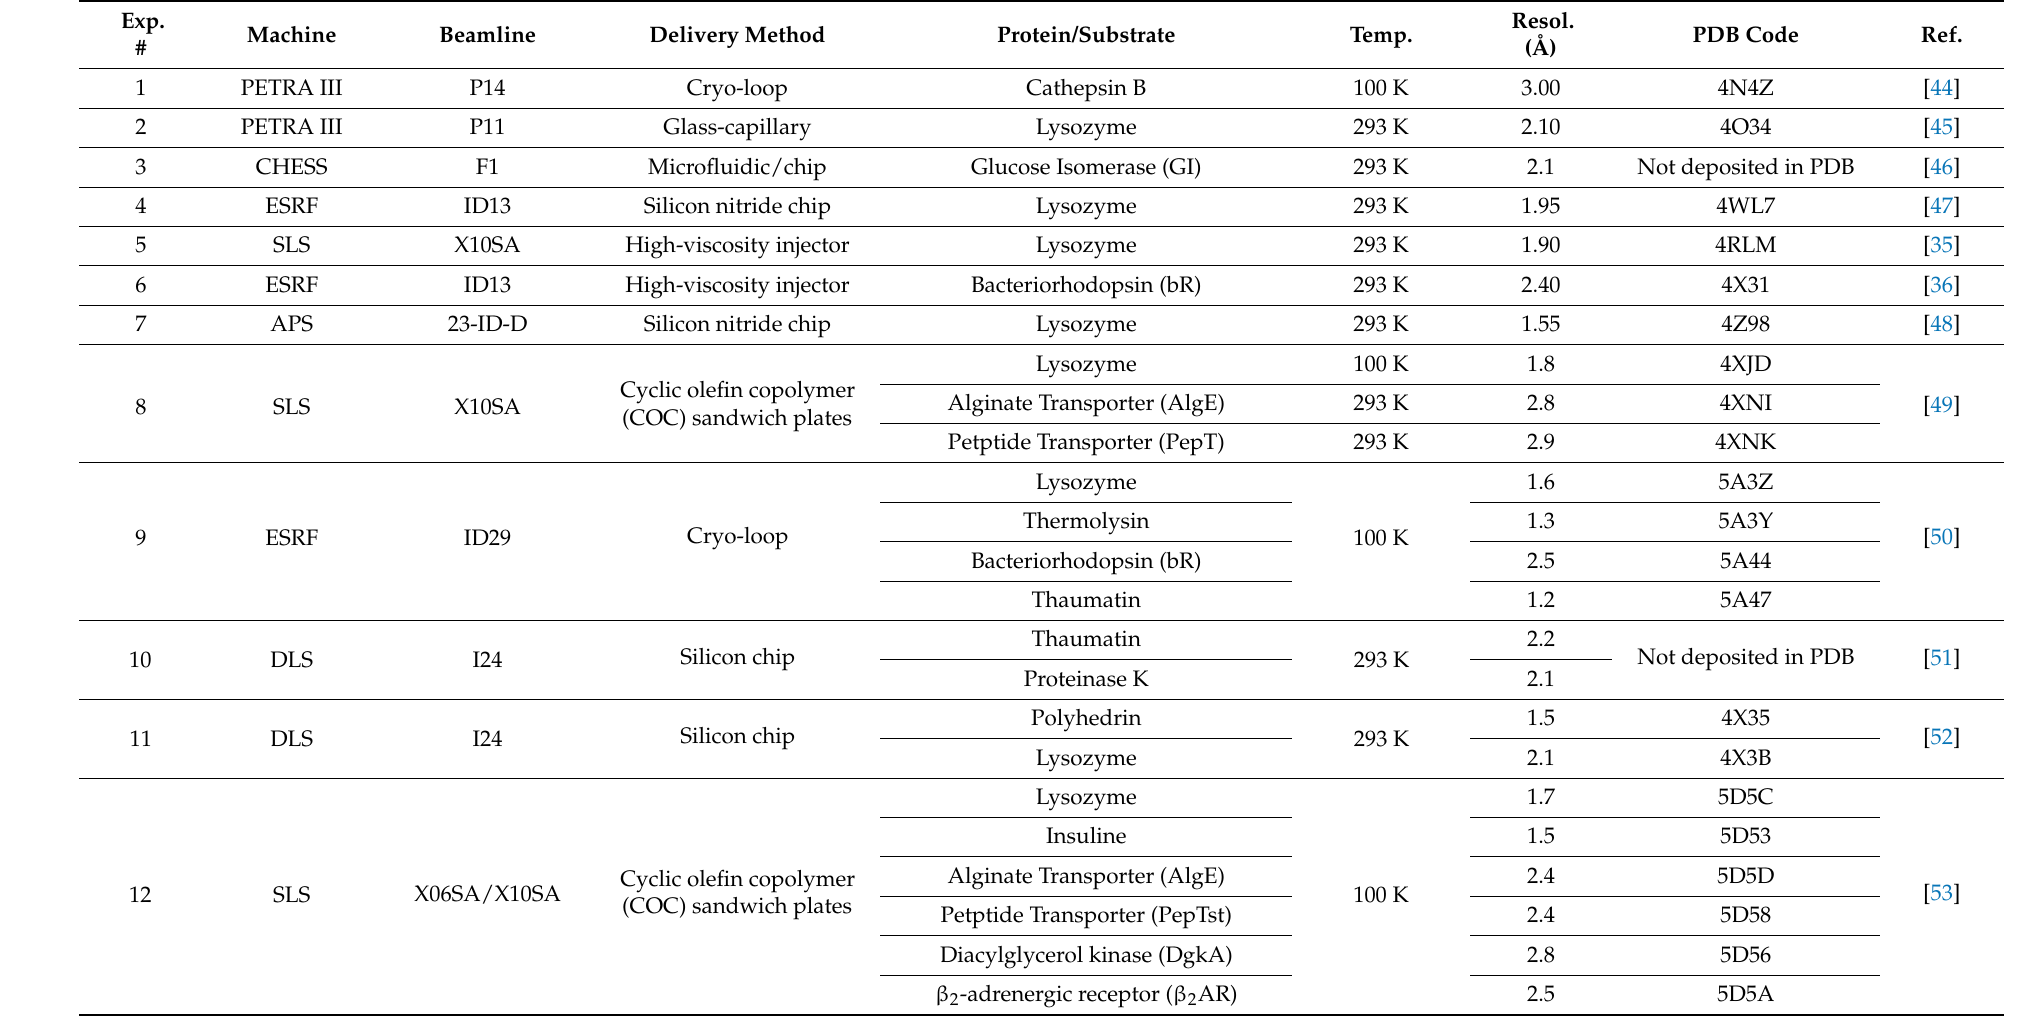
Table 1. SMX experiments carried out at synchrotron radiation sources. TR-SSX experiments are highlighted with asterisk.